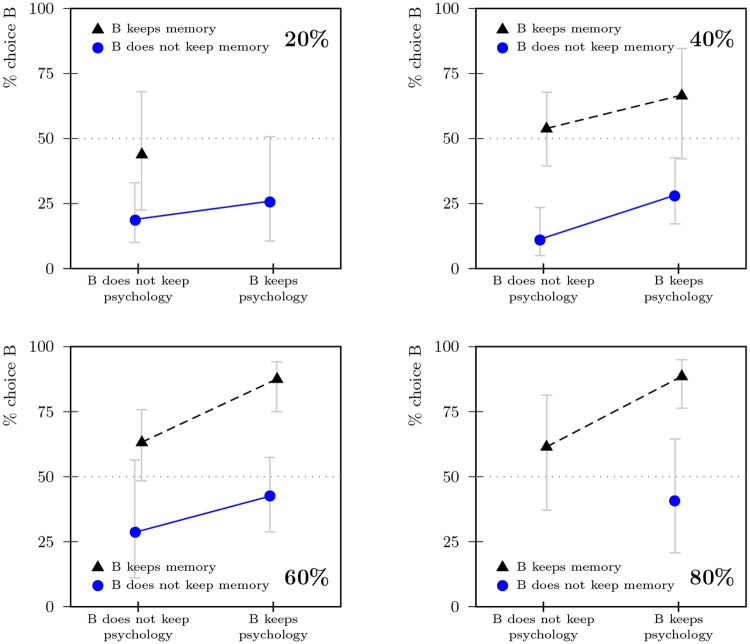
Relative frequency (in percent) of choosing person B as heir.Separate graphs summarize scenarios in which person B retains between one (20%) and four (80%) of the original dimensions. In each graph, allocations are shown for each possible division of the memory and psychology dimension. Note that B cannot retain both dimensions in the 20% condition and A cannot retain both dimensions in the 80% condition. Whiskers show the 99% confidence intervals around the means.